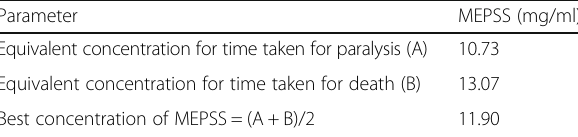
Table 2 Determinations of the best concentration of methanol extract of Piper sylvaticum stem for anthelmintic activity on Tubifex tubifex worms equivalent with standard drug Levamisole (1 mg/ml)